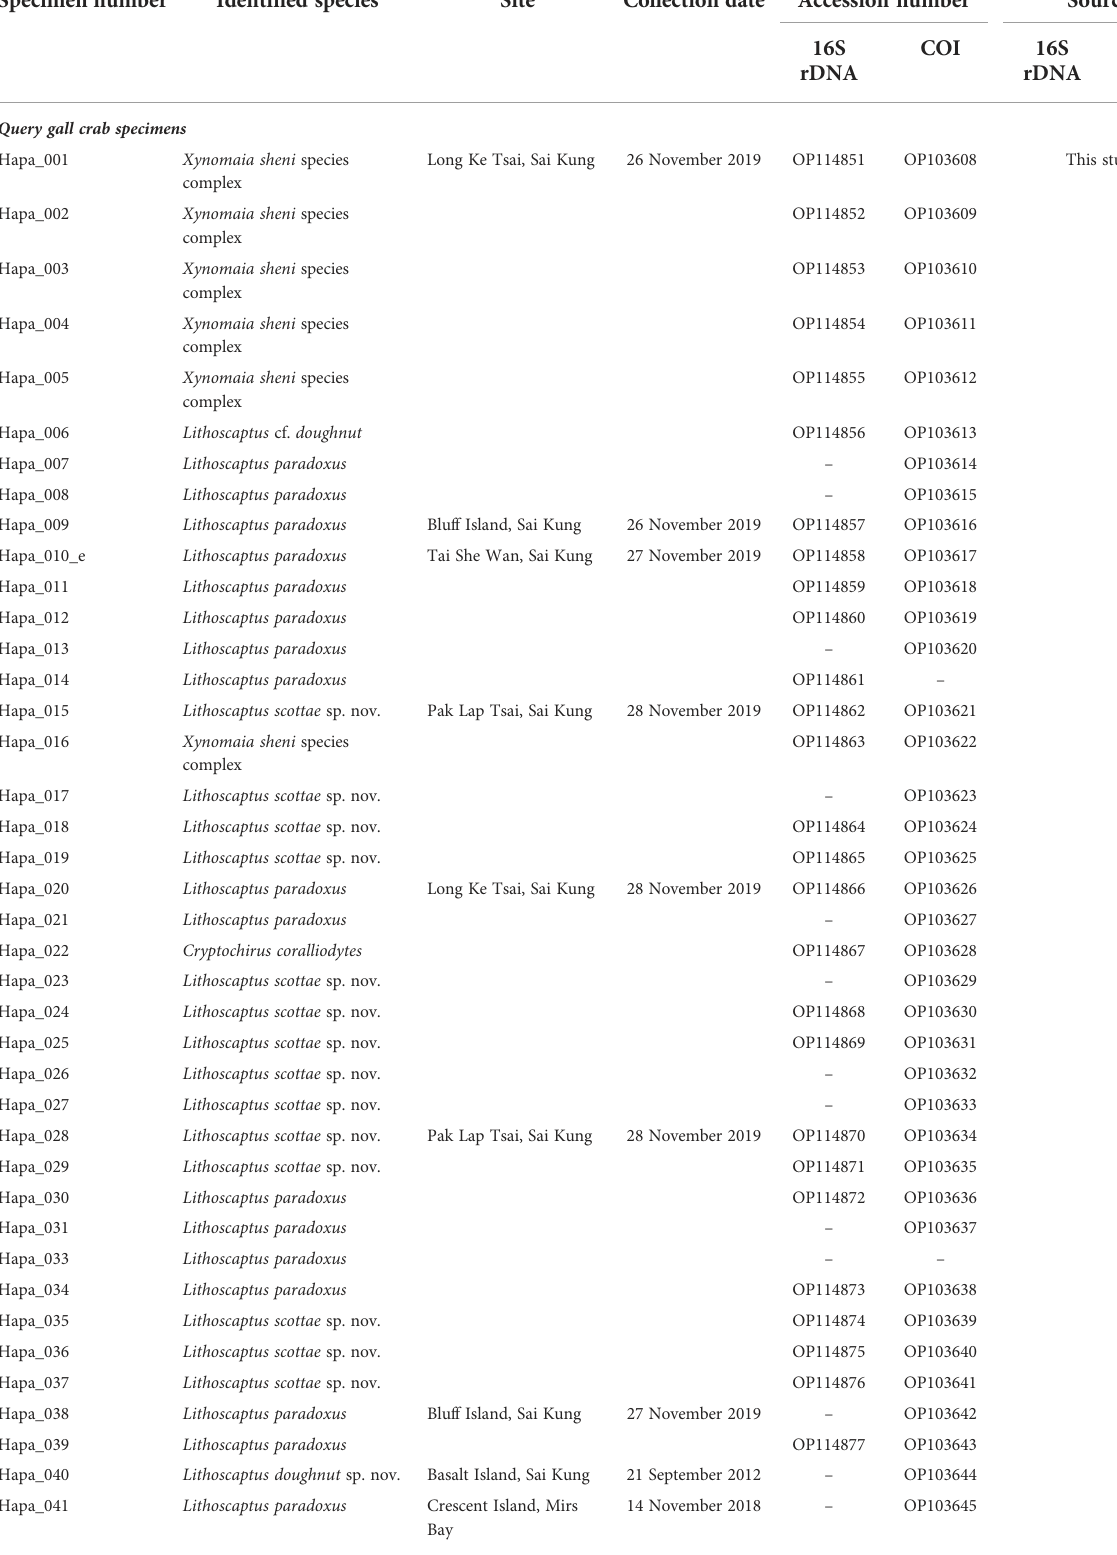
TABLE 1 Source of reference sequences: a, van der Meij, 2014; b, van der Meij, 2015a; c, van der Meij, 2015b; d, van der Meij, 2017; e, van der Meij and Nieman, 2016; f, van der Meij and Reijnen, 2014; g, van der Meij and Schubart, 2014. Specimen